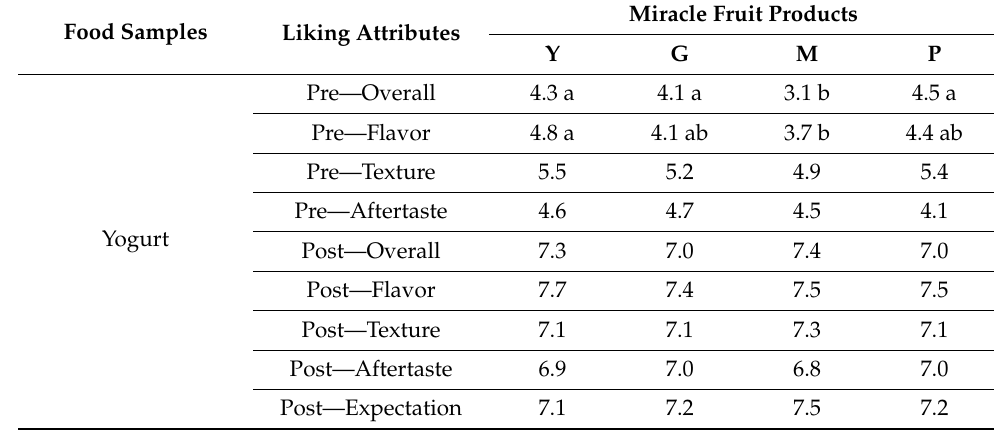
Table A1. Cont. Food Samples Liking